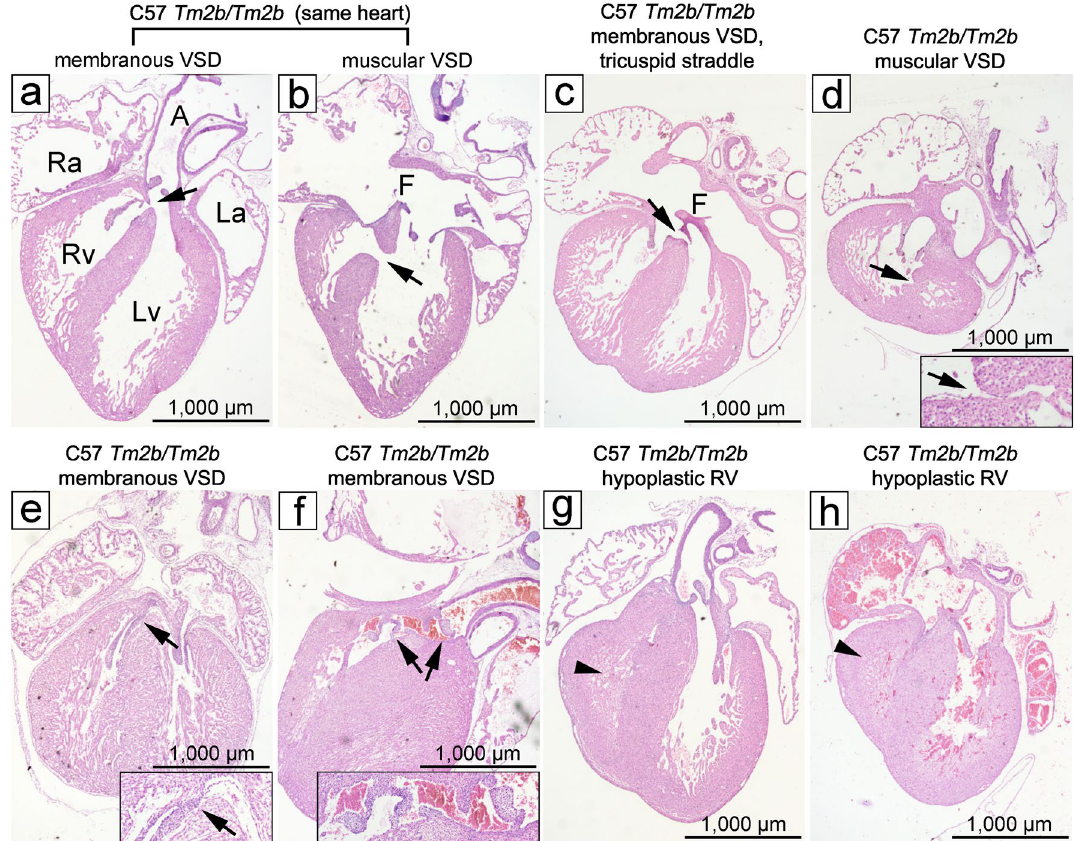
Figure 4. Loss of CECR2 results in VSDs. Defects were seen in coronally serial sectioned hearts of 5/22 Cecr2 Tm2b/Tm2b embryos E15.5–E18.5 embryos. One embryo ( a , b ) had both a membranous and muscular VSD (arrows). Four other embryos showed VSDs, one membranous VSD with a tricuspid straddle ( c ), one small muscular VSD ( d ) and two small membranous VSDs ( e , f ). Two embryos also showed hypoplastic right ventricles (RV) (arrowheads), appearing small throughout all serial sections rather than reflecting sectioning at an angle to the coronal plane ( g , h ). H&E staining. Heart images were taken at 2.5 × magnification, with insets at 10 × magnification. A-Aorta, La-left atrium, Lv-left ventricle, Ra-right atrium, Rv-right ventricle, F- foramen